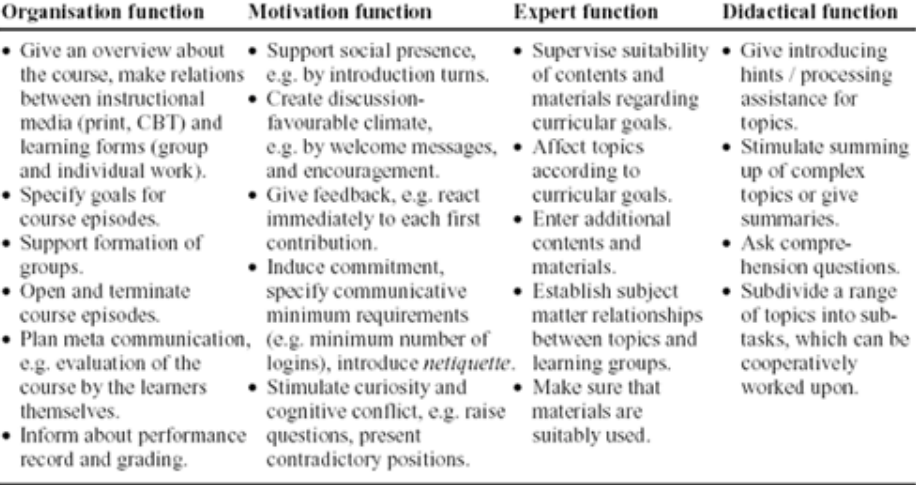
Consideration of the learners' characteristics is crucial to good CMC teaching. Sabry and Baldwin (2003) describe the influence of CMC on learning styles as